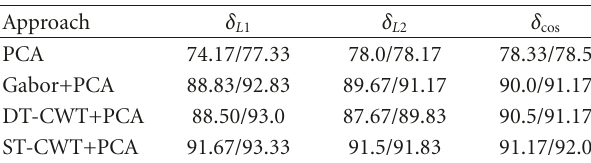
Table 5: Face recognition performance for di ff erent approaches using 200/400 features and FERET database with three di ff erent similarity measures.